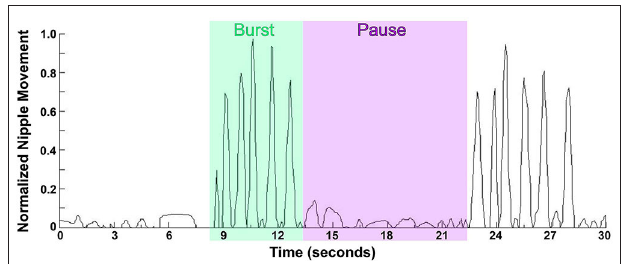
FIGURE 1 | Waveform pattern of NNS. Graph represents the extent of the movement of the lever inside the bottle nipple, measuring the expression component of sucking with 1.0 being the furthest the lever inside the nipple can move, and 0.5 being half the maximum distance. NNS occurs at up to two sucks per second in short, fast bursts lasting anywhere from 2 to 12s with a pause between bursts of